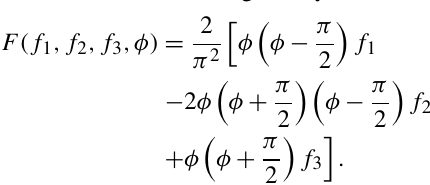
where F is the function given